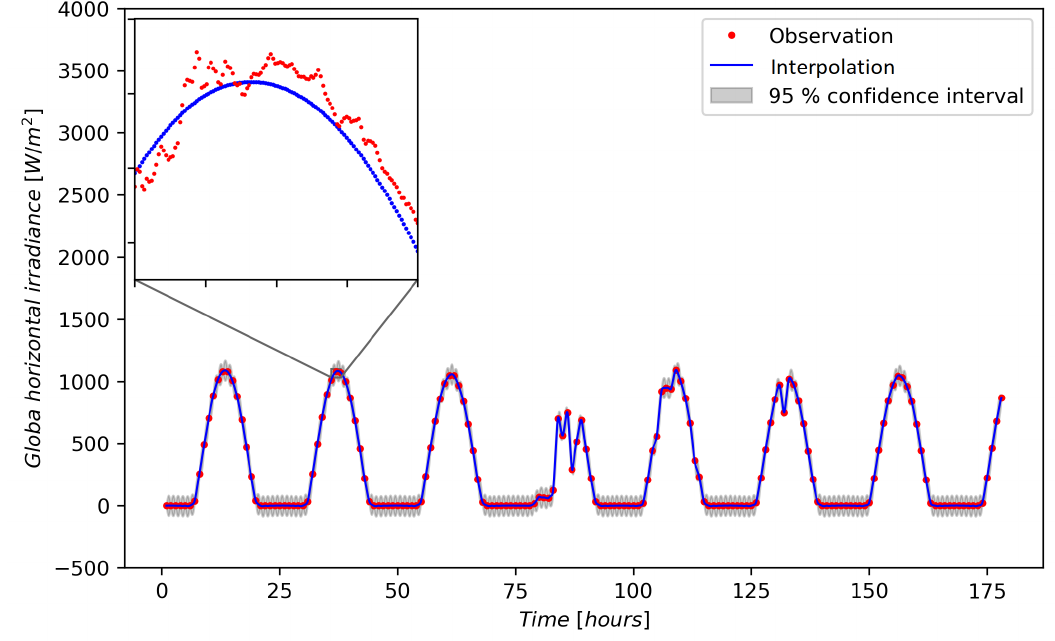
Figure 8. Gaussian process regression of one-hourly averaged global horizontal irradiance (GHI)-data, where no meter failure is present, with a Per × RQ kernel. Inlay: the points constituting the Gaussian process regression, together with observations of GHI, sampled every minute.